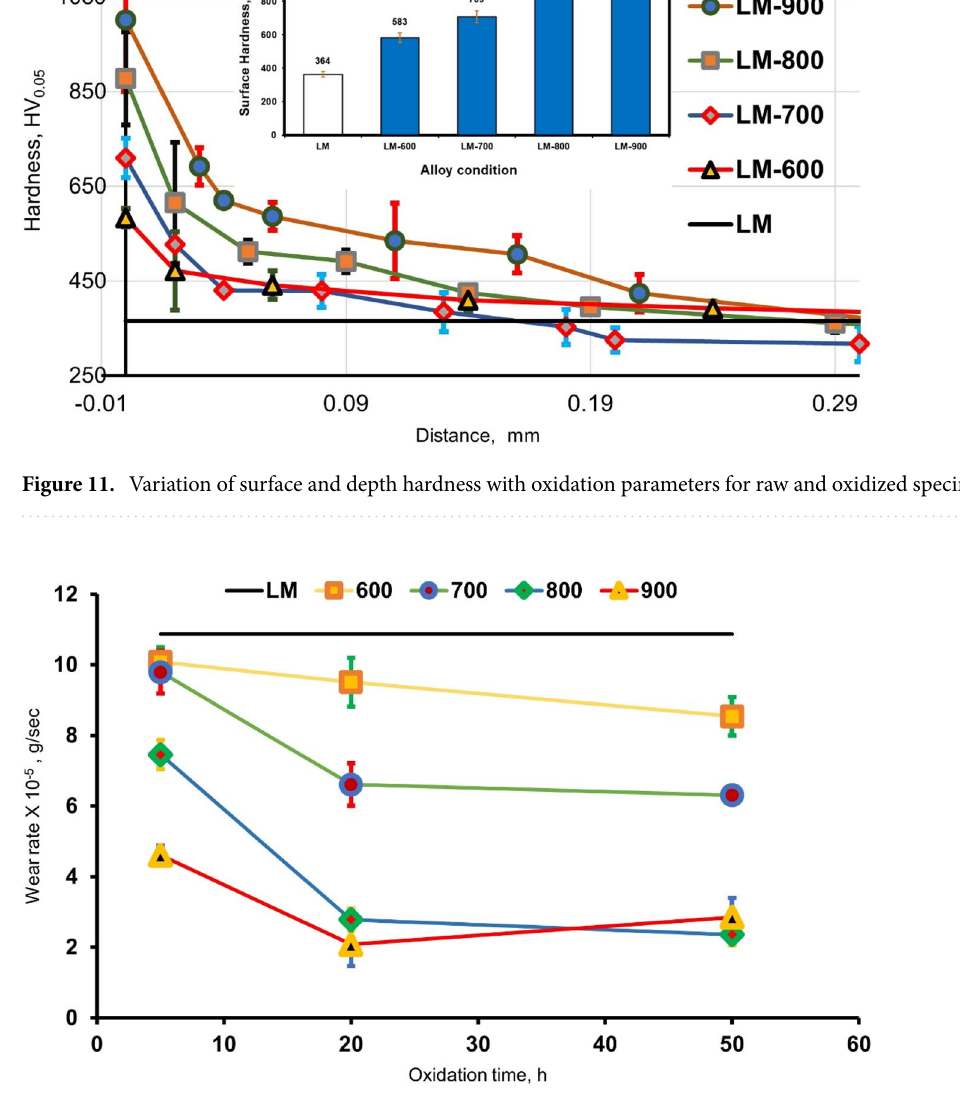
Figure 12. Wear rate of raw and oxidized specimens at different temperatures and